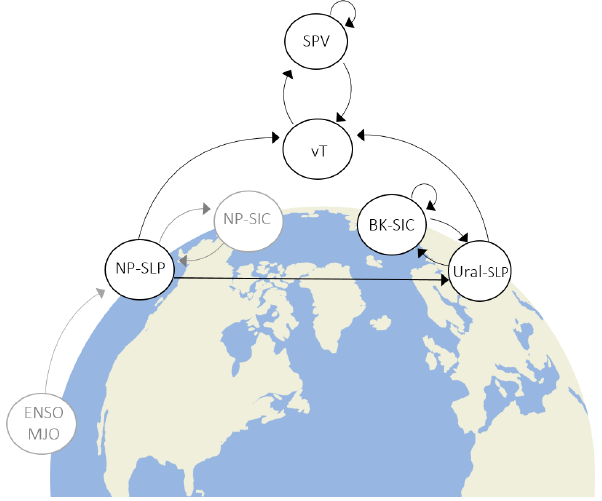
Figure 3. Assumed causal model. Nodes in black contours rep- resent the involved processes in the causal model: Barents and Kara sea ice concentrations (BK-SIC), sea level pressure over the Ural Mountains (Ural-SLP) and over the North Pacific (NP-SLP), lower-stratospheric poleward eddy heat flux ( vT ), which is the up- ward wave forcing of the stratospheric circulation, and the strato- spheric polar vortex (SPV). The black arrows represent the corre- sponding causal relationships which are here assumed to operate on a monthly timescale. The grey contoured nodes of the North Pacific sea ice concentrations (NP-SIC) and El Niño–Southern Oscillation/Madden–Julian Oscillation (ENSO/MJO) and the re- spective arrows denote processes discussed in the literature but not explicitly accounted for here because their effects are assumed to be mediated by